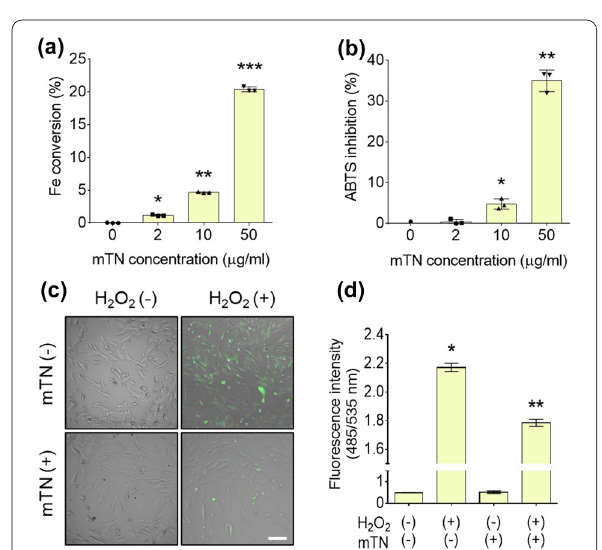
Fig. 4 a Fe conversion and b ABTS inhibition assay results for various concentrations of mTNs. Significantly different compared ∗ to the group treated with no nanoparticles ( p < 0.05). c DCF‑DA assay images and d quantitative analysis of the fluorescence intensity of hADSCs cultured with or without H 2 O 2 and mTNs (scale bar 100 μm). *Significantly different compared to the H 2 O 2 ( )/mTN = − ( ) group ( p < 0.05) Fig. 5 a Schematic illustration of the anti‑inflammation activity of − mTNs in a mouse peritonitis model and the experimental timeline. ELISA results for ( b ) IL‑6 and ( c ) TNF‑α in the blood. *Significantly different compared to N.C. ( p < 0.05). ELISA results for ( d ) IL‑6 and ( e ) TNF‑α in the peritoneal fluid. N.C mice were treated with DW only while the P.C group was treated with zymosan only. *Significantly different compared to the N.C group ( p <